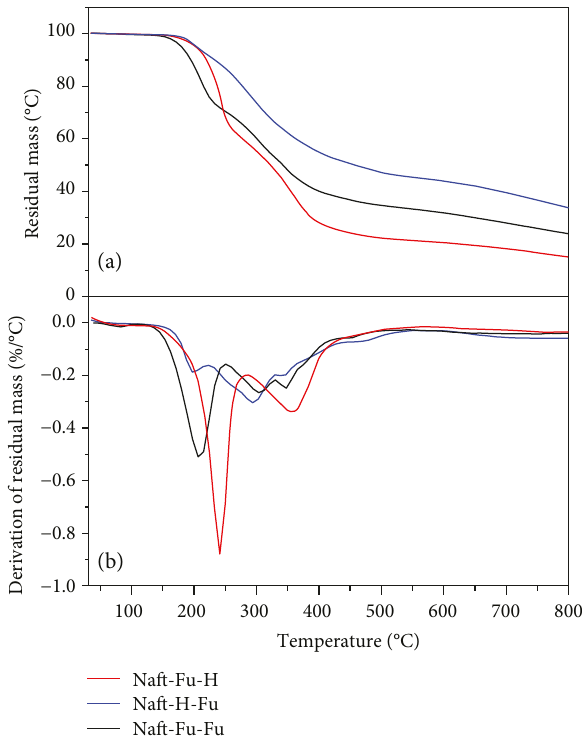
Figure 9: Thermograms of naphthoxazines containing furan groups. (a) TGA, (b) DTGA. Table 2: Summary of the values of TGA thermograms of the naphthoxazines.